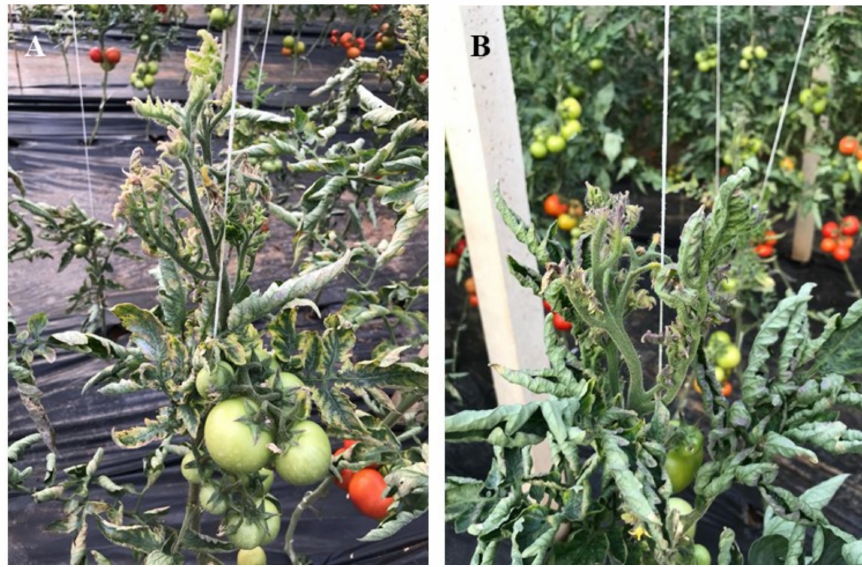
Figure 9. Stolbur disease symptoms induced by Candidatus Phytoplasma solani. ( A ) Reduced size and yellowing of leaves. ( B ) Distorted and curled